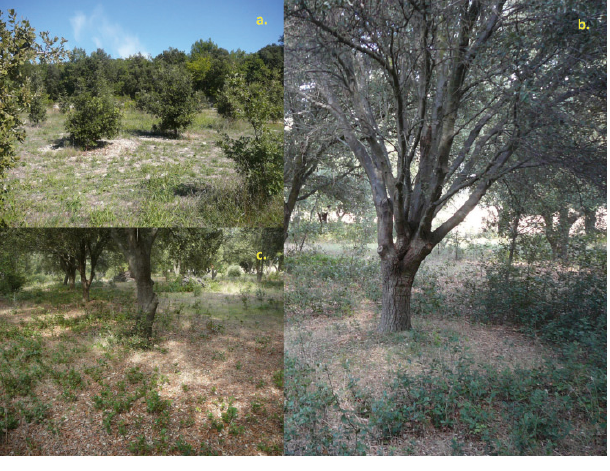
Fig. 2 . The holm-oak ( Quercus ilex L.) and black truffle ( Tuber melanosporum Vittad.) rural forest; development of burnt and successional stages after plantation. (a) Burnt areas surrounding new inoculated holm-oak plantations in abandoned vineyards; (b) A burnt area at the foot of a 30- year-old holm-oak with traces of branches lopping in the lower part of the trunk; (c) Old inoculated holm-oak plantation in Uzès managed as